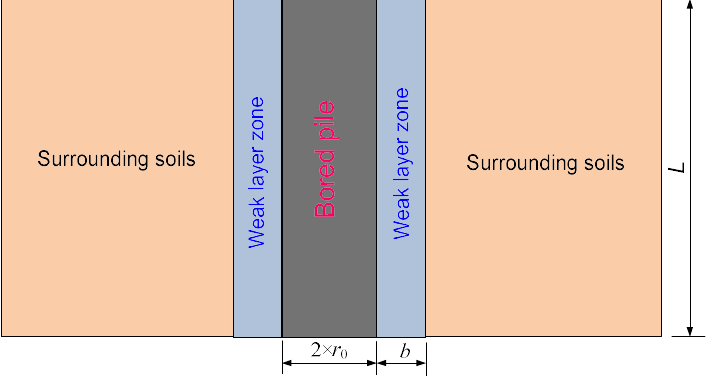
Figure 1. Calculation model of the post-grouted pile foundation.